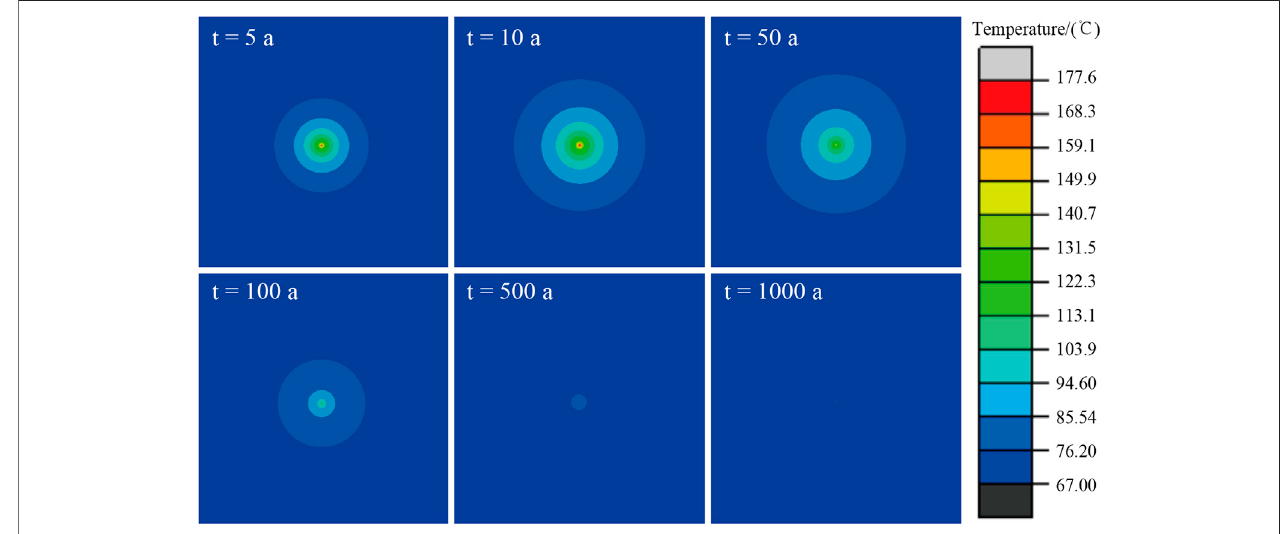
FIGURE 11 | The characteristics of the temperature fi eld of the repository in 1,000